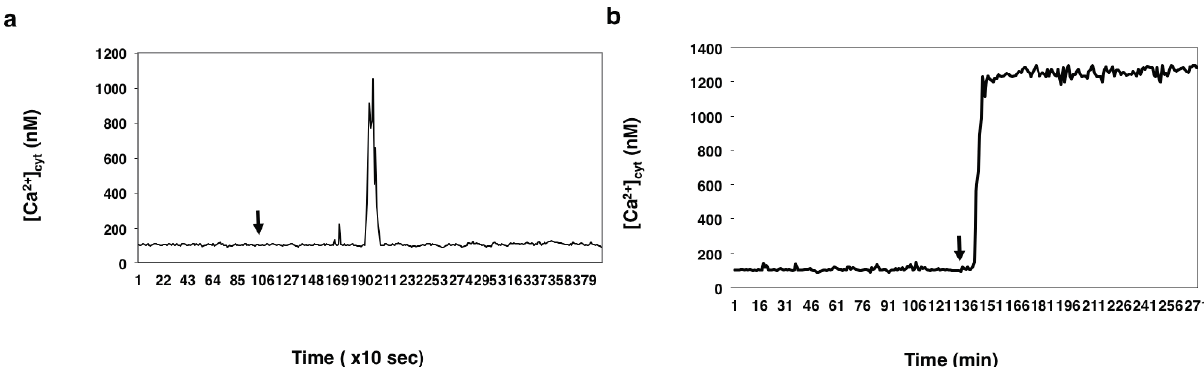
Figure 7. The effect of thapsigargin added at ( a ) 10 µM and at ( b ) 100 µM concentration on the cytosolic calcium level of unfertilized wheat egg cells incubated in IVF medium containing 2 mM CaCl 2 . Arrows: addition of